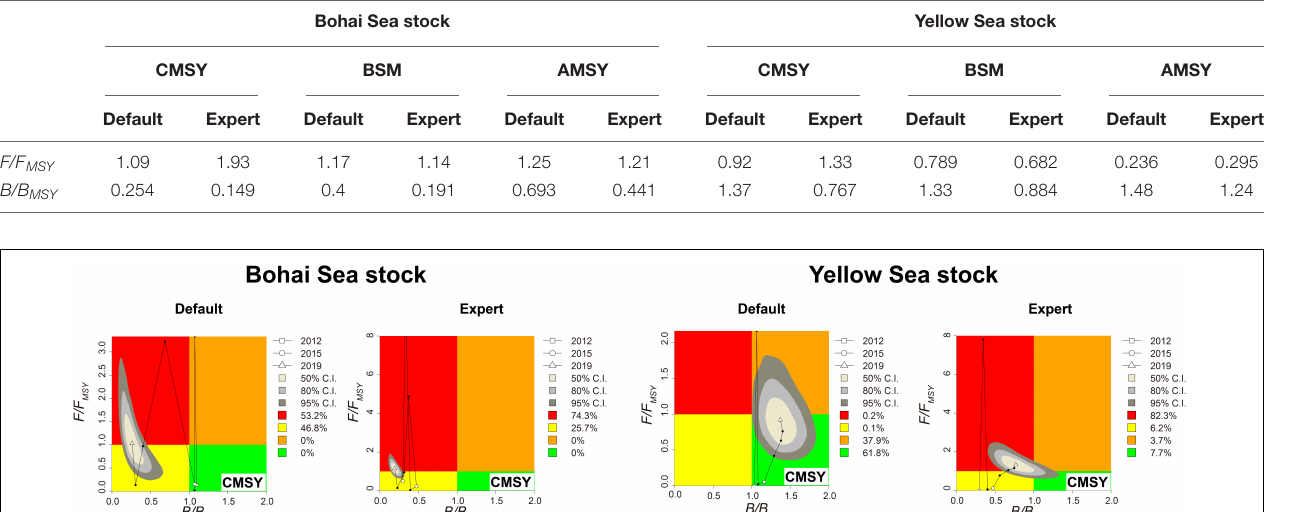
TABLE 3 | The main outputs of CMSY, BSM, and